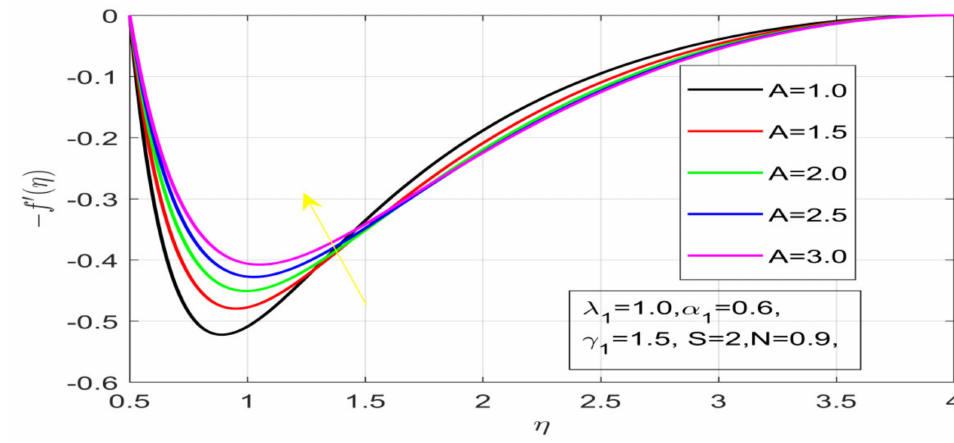
Figure 6. Impact of A on the velocity profile.